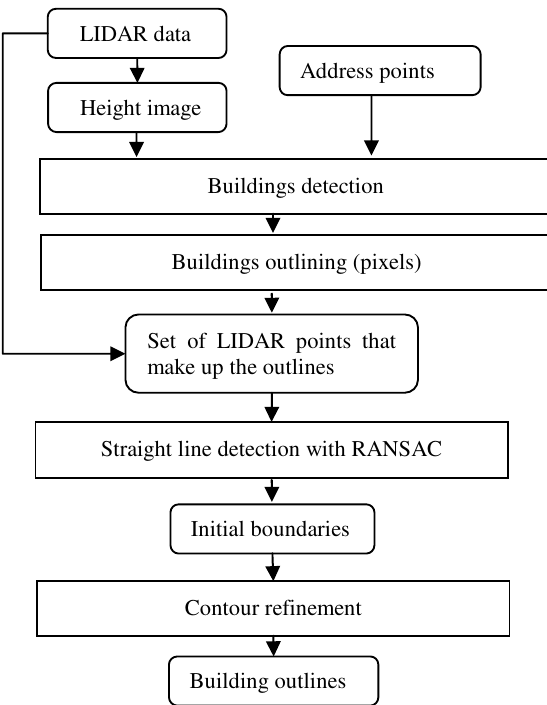
Figure 1. The workflow of outline